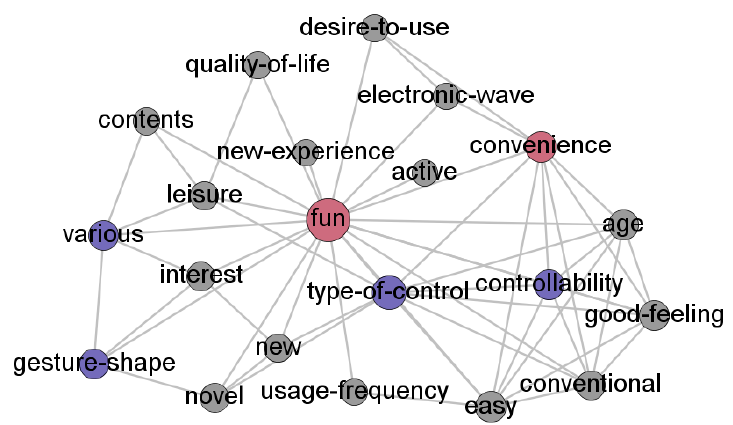
Figure 5. Partial semantic network of fun (red and blue nodes indicate core values and design variables, respectively).